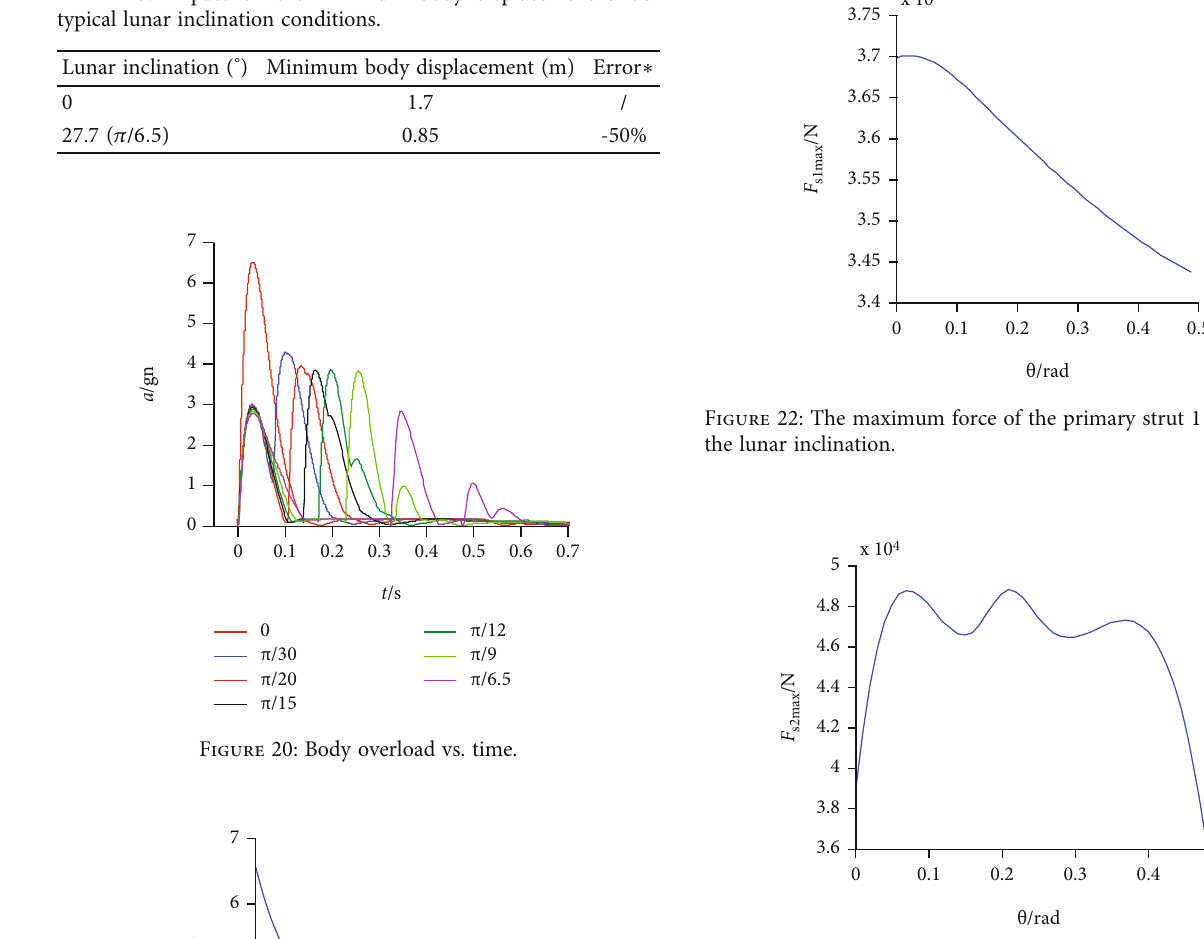
Figure 23: The maximum force of the primary strut 2 varies with the lunar